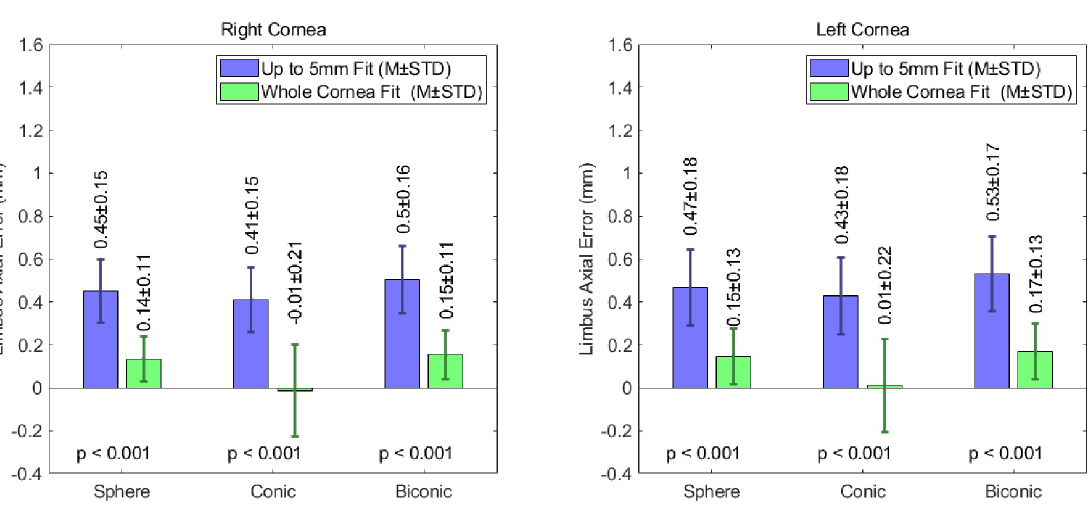
Fig 6. Limbus axial position error of fitted limbus compared to detected limbus when spherical, conic and biconic fitting modelling techniques.